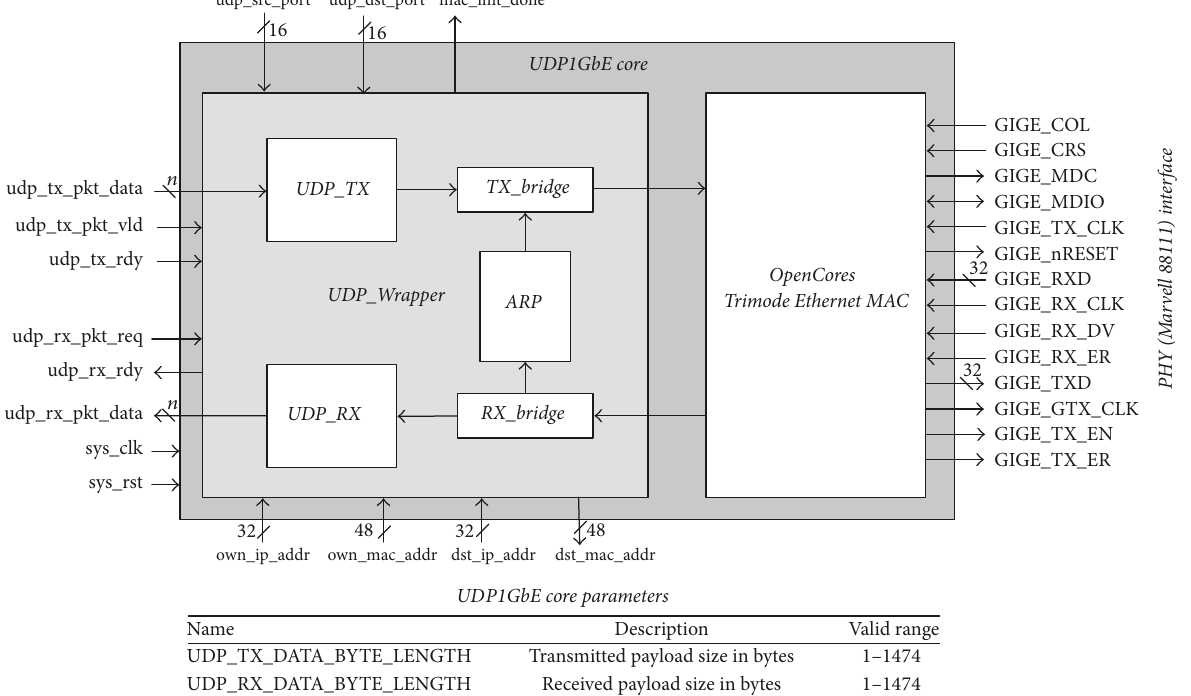
Figure 11: Structure of UDP/IP core for interfacing and control of a Gbe (uses OpenCores Trimode Ethernet MAC [5] to interface with a